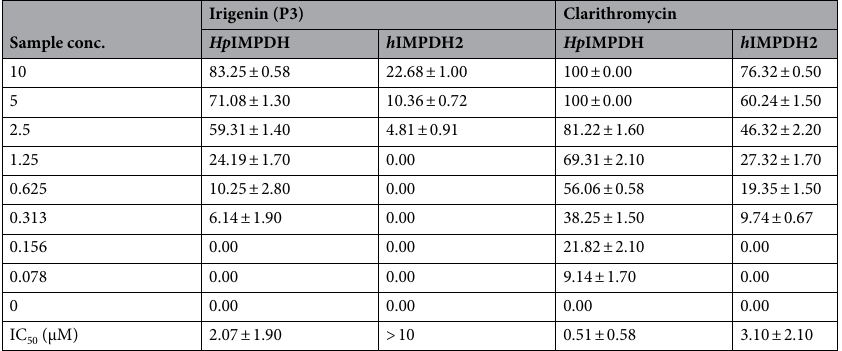
Table 2. Hp IMPDH and h IMPDH2 inhibitory activity of irigenin (P 3 ) and the standard drug clarithromycin.